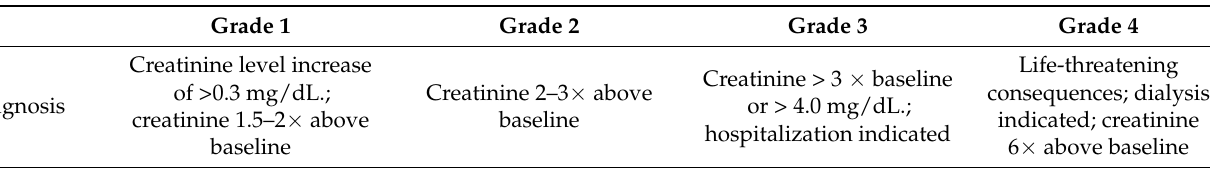
Table 4. American society of clinical oncology grading and treatment of renal immune-related adverse events (adapted from